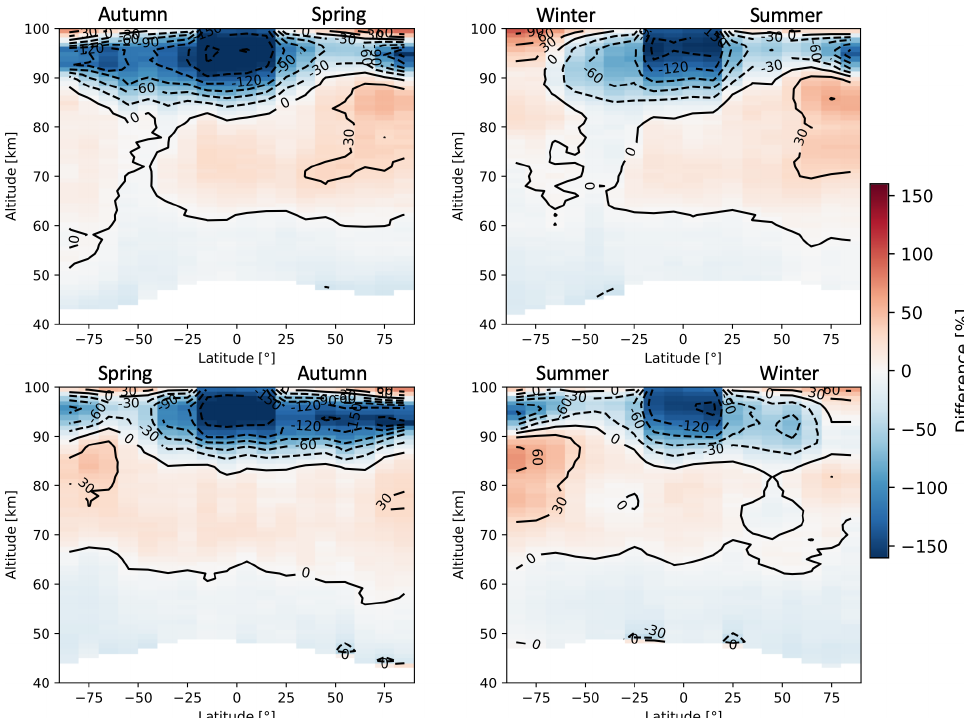
Figure A14. Seasonal zonal means of H 2 O FM13 SMR–MIPAS upper atmosphere relative differences averaged over the time period indi- cated in Table 2. The seasons are intended as astronomical seasons, i.e. each starting at the respective solstice or equinox.